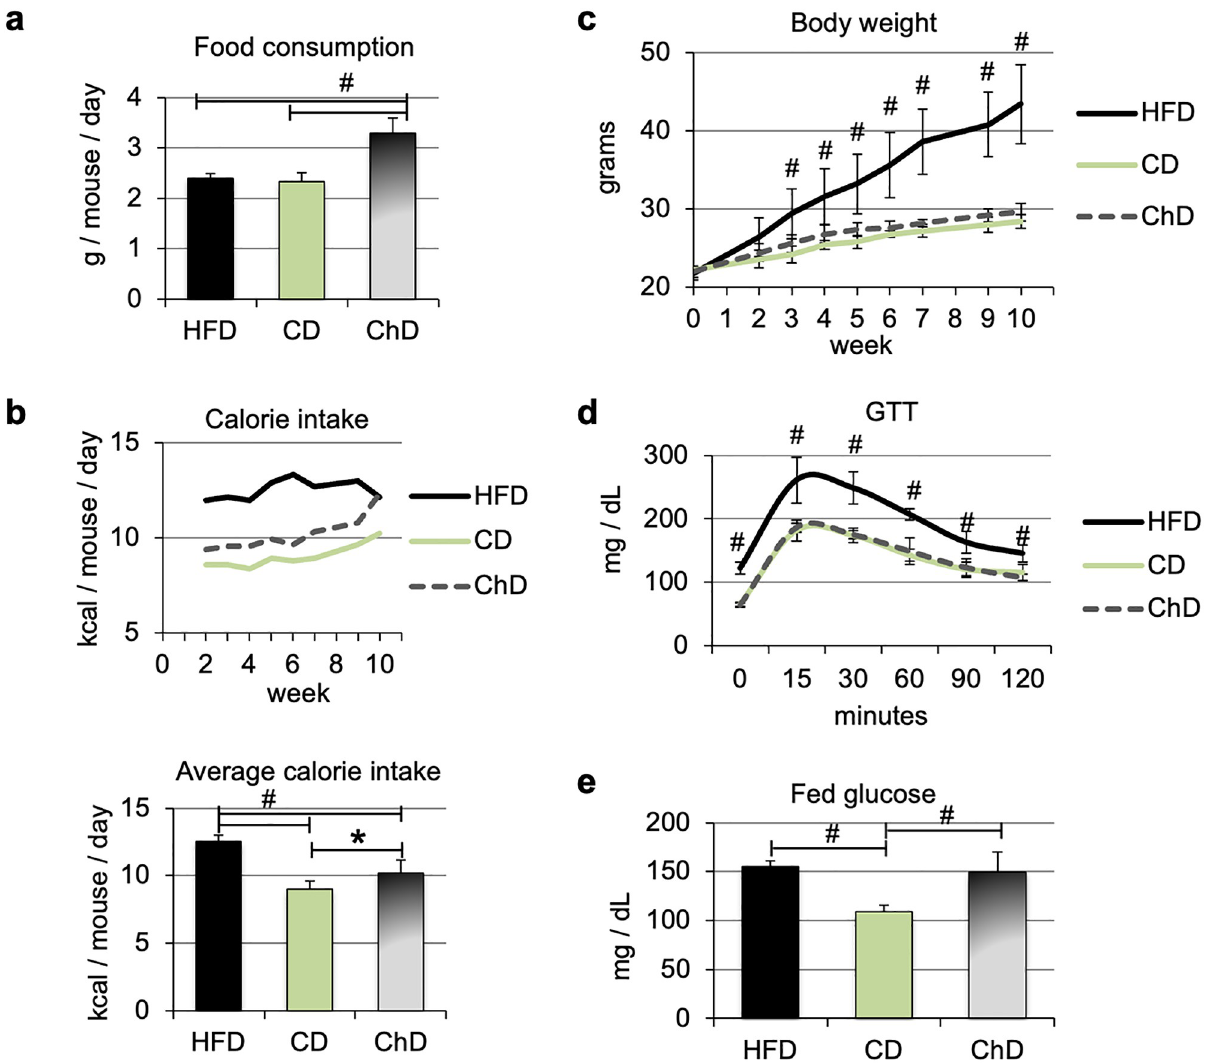
Fig 1. Increased body weight gain and development of glucose intolerance in high fat diet fed C57BL/6 mice. C57BL/6 mice were fed a HFD, a matched purified ingredient control diet (CD), or a regular chow diet (ChD) for 10 weeks. (a) Average food consumption; # p < 0.01 (n = 5); (b) Calorie intake throughout the experimental period and average intake � p < 0.05, # p < 0.01 (n = 5); (c) Body weight gain. Starting from week 3, body weights between HFD-fed and CD were significantly different at p < 0.01; HFD versus ChD groups were also significantly different, although weeks 3, 4 and 5 at a lower p value (p < 0.05); (d) Glucose tolerance test. Mice were fasted overnight and given a bolus of glucose (1 mg/g body weight). Blood glucose was monitored at the indicated time points. The indicated time points in the HFD-fed group were significantly different relative to the CD as well as ChD groups; (e) Fed blood glucose after 10 weeks of feeding the special diets; # p < 0.01 (n =